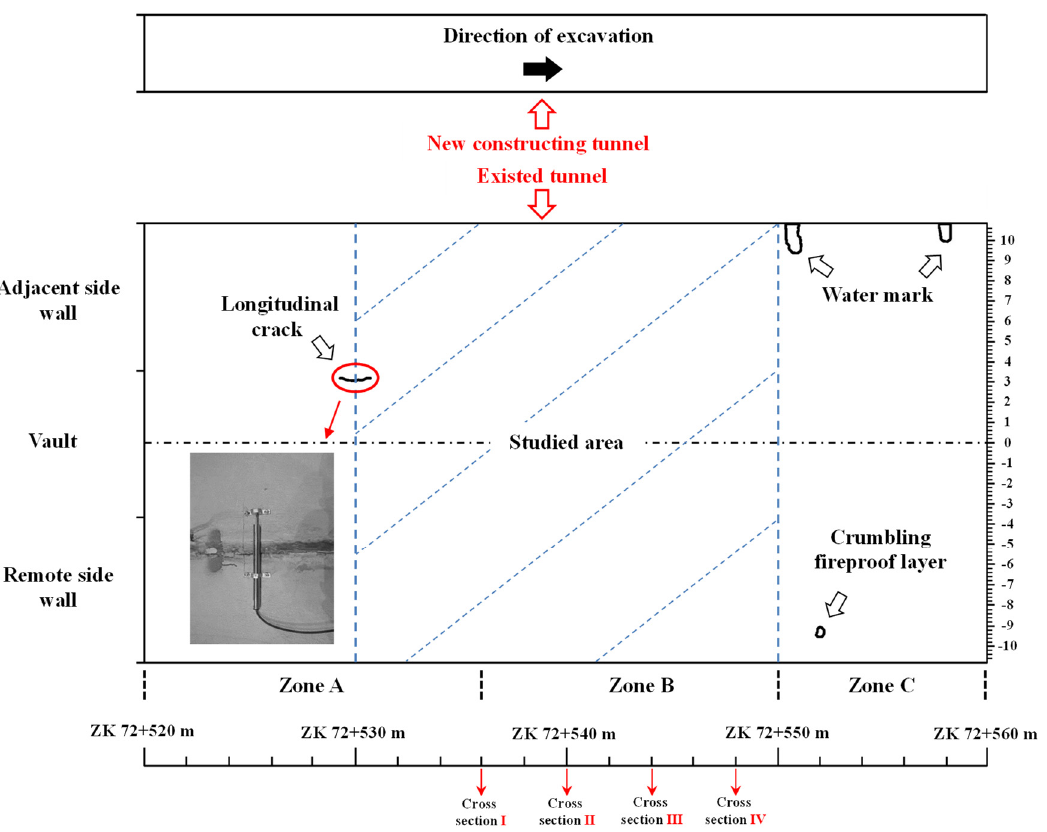
Figure 3. Studied area of new constructing and existed tunnels. Table 1. Determination of